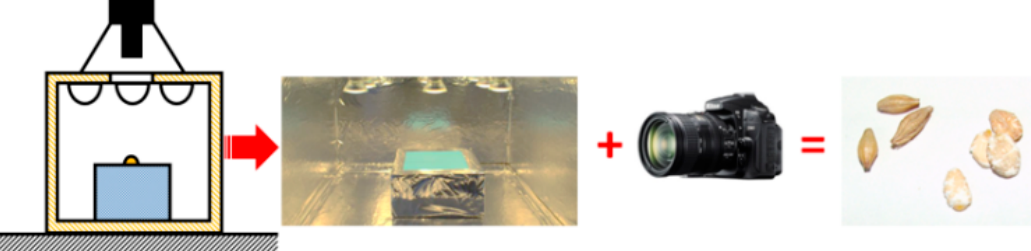
Figure 2. The test stand used to capture images under the project.